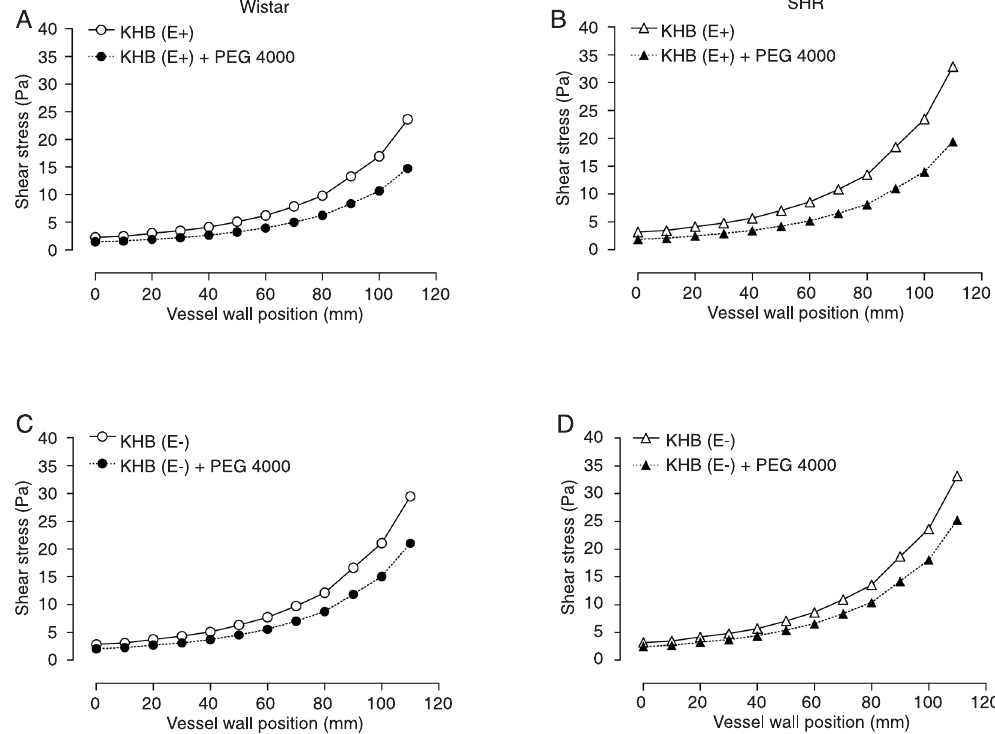
Figure 5. Distribution of wall shear stress along the vessel wall from the base (0 mm) to the end (110 mm) simu- lated for the mean of the maximum value of pulsatile cycle represented in Figure 2 at a flow of 2.5 mL/min. N = 4-6 animals in each group. A and B , Effect of PEG 4000 on the wall shear stress (Pa = Pascal) along the wall of the tail arterial bed with intact endothelium (E+) from Wistar rats and spontaneously hypertensive rats (SHR), respectively; C and D , effect of endothelial damage (E-) on PEG-induced changes in wall shear stress in the tail arterial beds from Wistar rats and SHR, respectively.